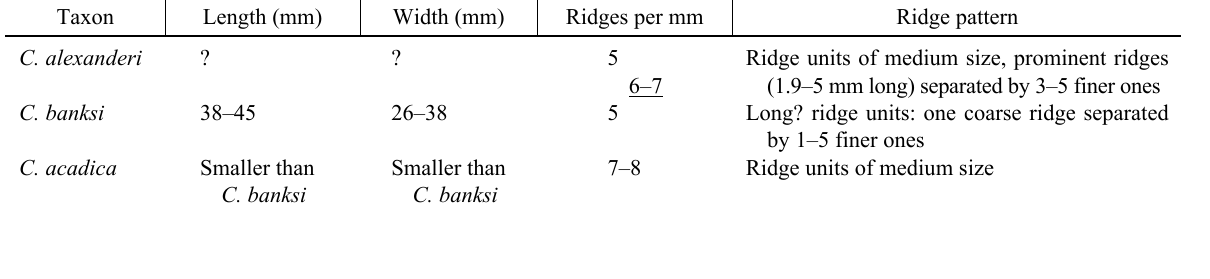
Table 2. Comparison of three Cyathaspis species. Explanations: ventral measurements are underlined; data for Cyathaspis banksi and C. acadica from Denison (1964)